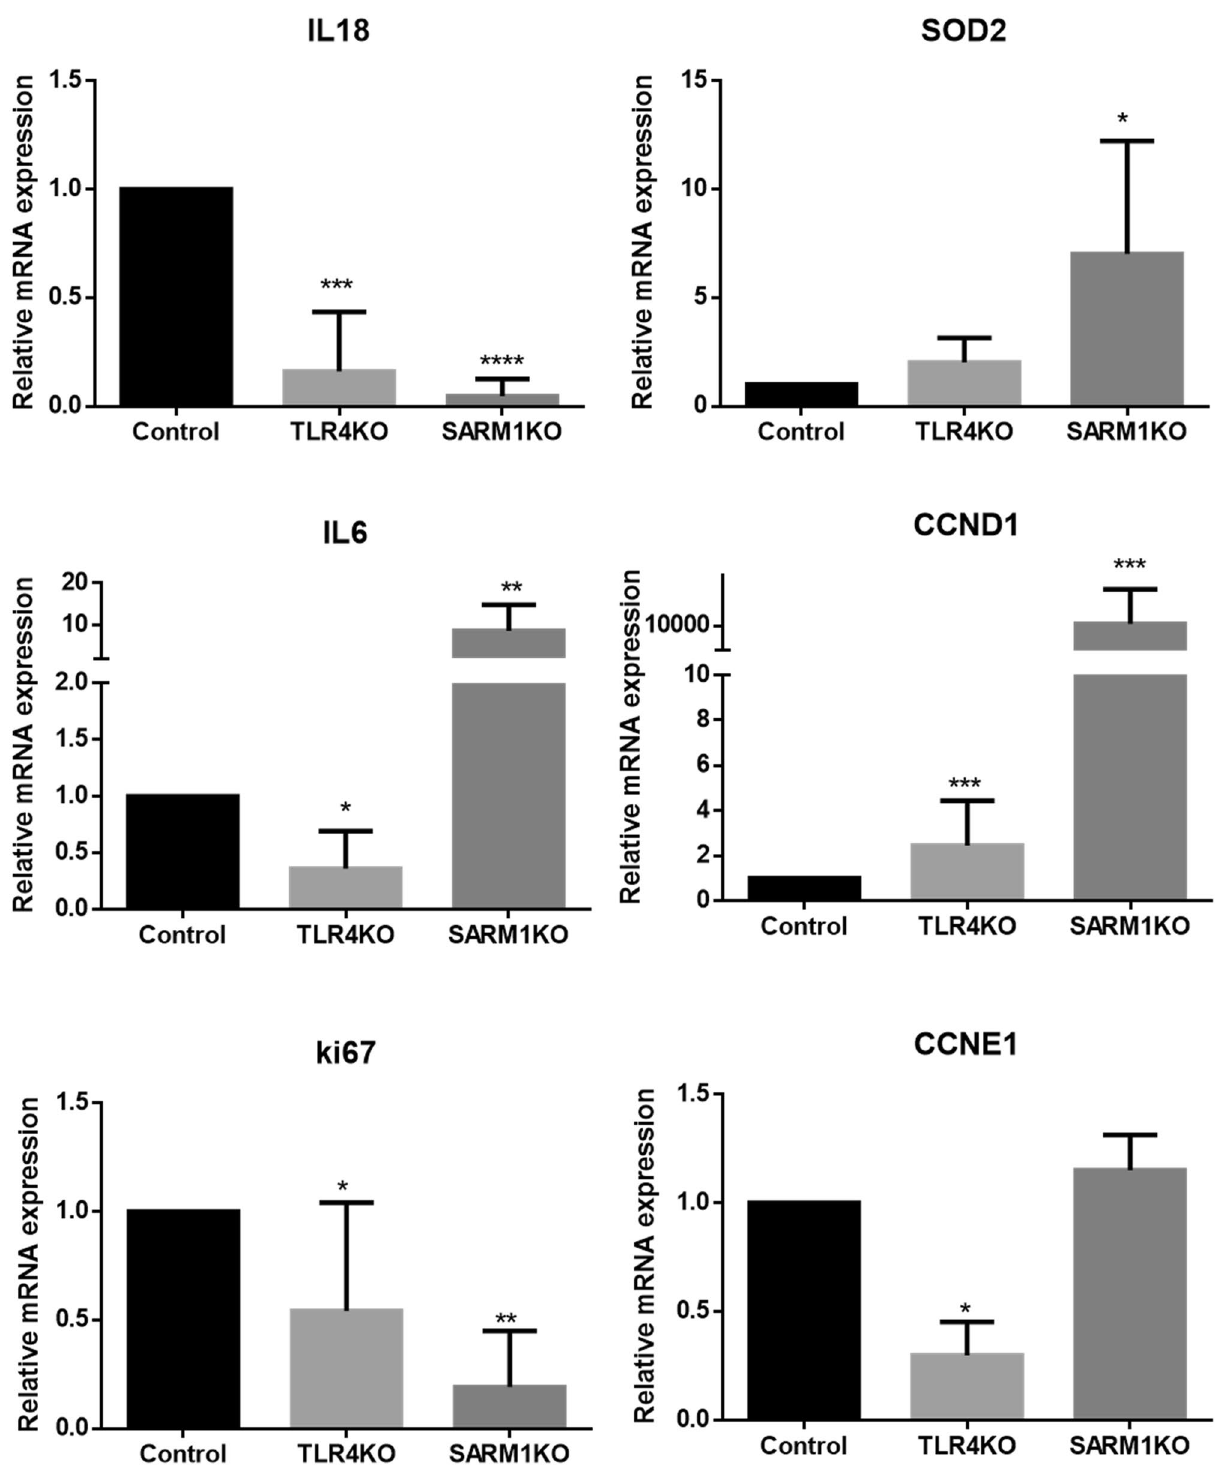
Figure 6. TLR4KO and SARM1KO modulate the expression of genes related to inflammation and proliferation. Data obtained by quantitative RT-PCR analysis of three biological replicates for IL18 , IL6 , CCND1 , CCNE1 , SOD2 and Ki-67 in TLR4KO, SARM1KO and parental HeLa cells. Data displayed as mean ± SD. (* p ≤ 0.05; ** p ≤ 0.01; *** p ≤ 0.001; **** p ≤